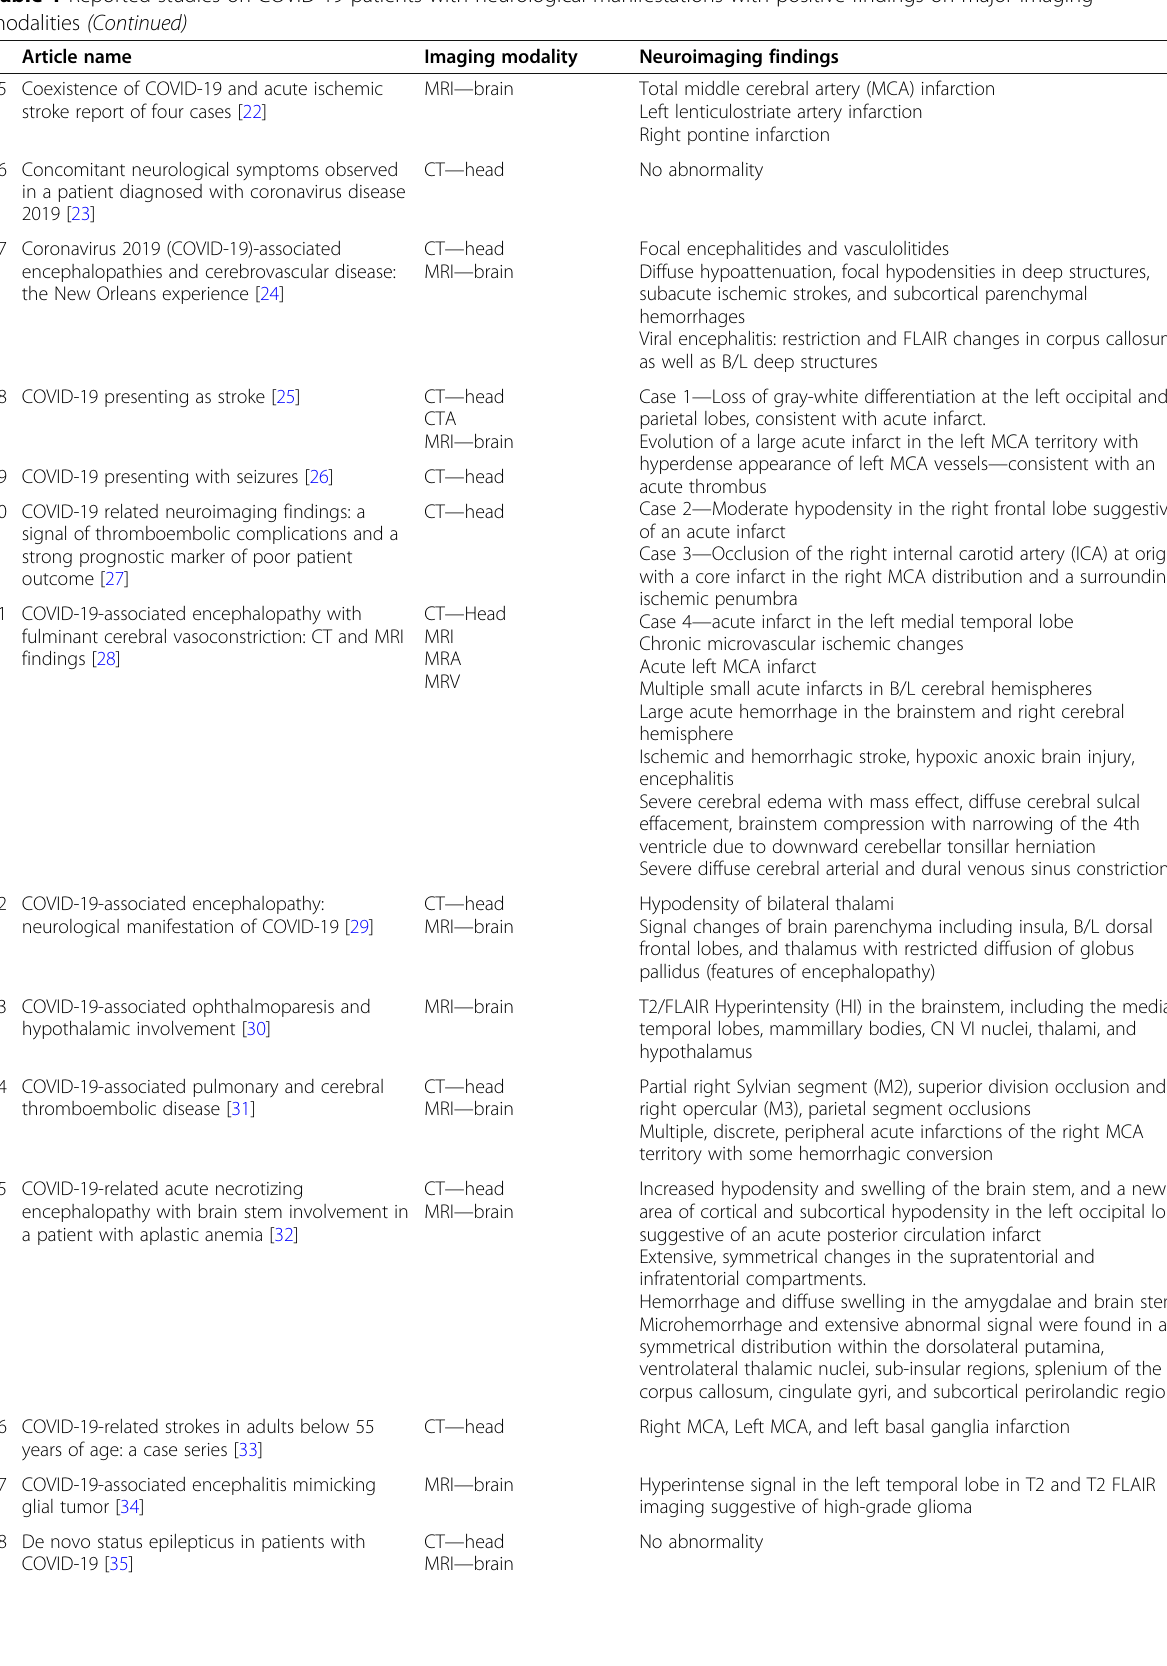
Table 1 Reported studies on COVID-19 patients with neurological manifestations with positive findings on major